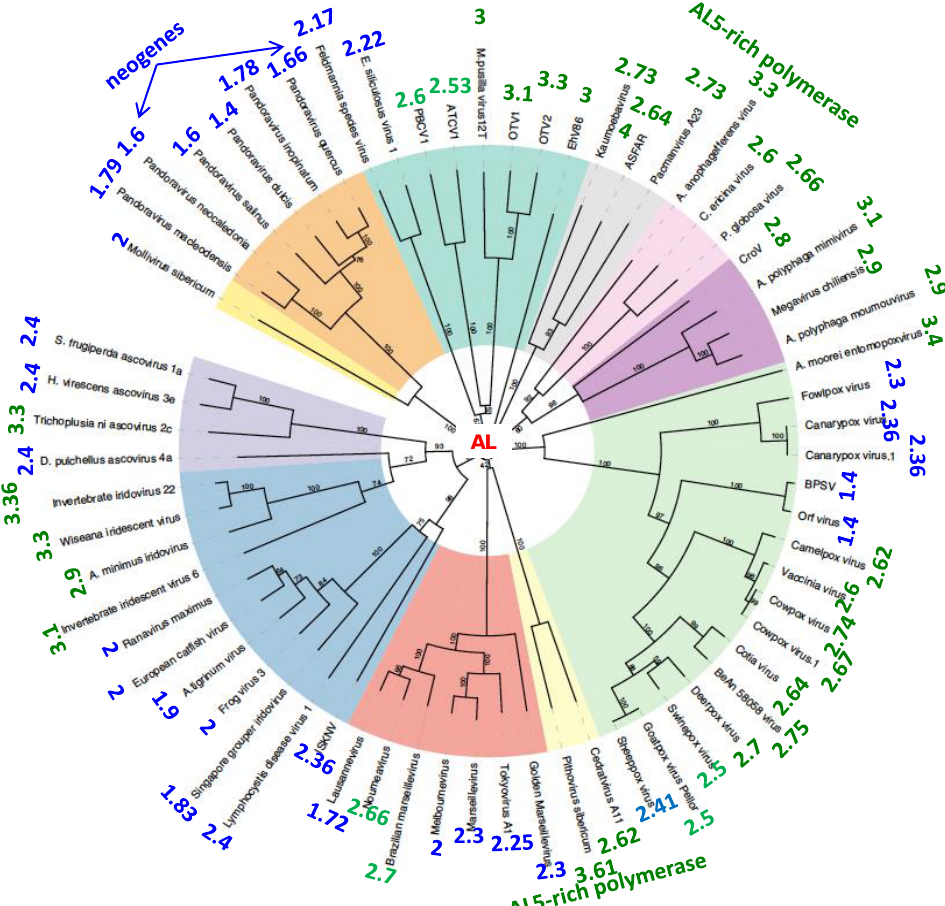
Figure 2. Giant viruses classification tree. The numbers at the periphery of the circular tree (from [58]) indicate the ALPHA pentamer-proximity P 22 of the Giant viruses genomes to the ALPHA